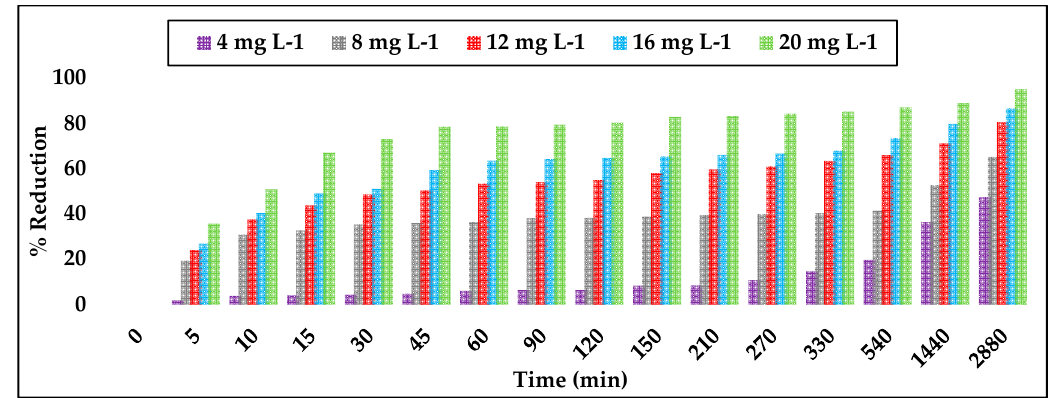
Figure 4. Evolution of simazine reduction over time with different doses of PAC. Experimental conditions: [Simazine 0 ] = 0.7 mg L − 1 ; [PAC] = 4, 8, 12, 16 and 20 mg L − 1 ; pH 0 6.7; T = 25 °C.